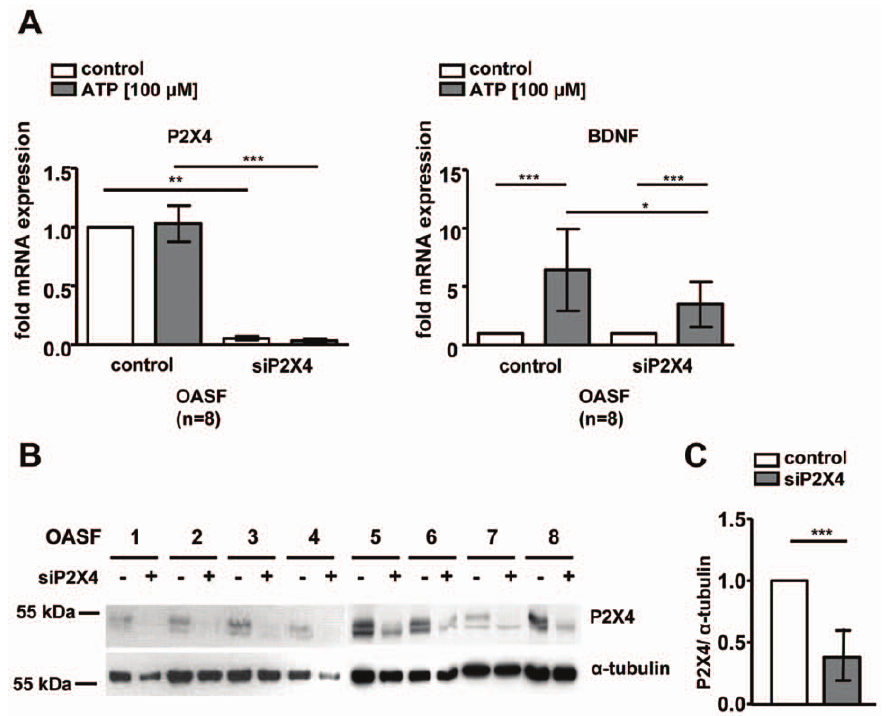
Figure 4. Purinergic receptor P2X4 siRNA transfection in OASF (n=8). Endogenous P2X4 expression in OASF was reduced by siRNA transfection before ATP (100 m M) stimulation for 2 h. A . P2X4 mRNA expression was reduced compared to scrambled controls. The ATP-induced BDNF mRNA expression in P2X4 siRNA transfected cells was reduced compared to scrambled controls. B . P2X4 protein levels were reduced by P2X4 siRNA transfection compared to scrambled controls. a -tubulin levels in P2X4 siRNA transfected cells were slightly decreased compared to